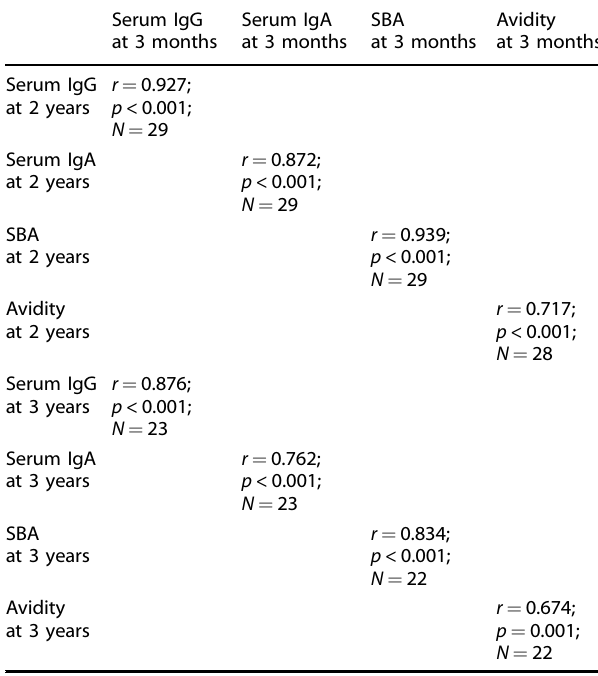
Table 1. Spearman ’ s correlations between the levels of the humoral immune response parameters 3 months and 2 and 3 years after vaccination, in recipients of 2 or 10 µg OS doses of SF2a-TT15 (non- adjuvanted and adjuvanted).